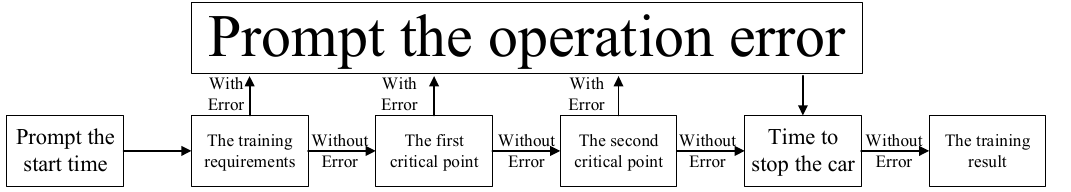
Figure 15. The voice prompt and their steps in the process of reverse parking.